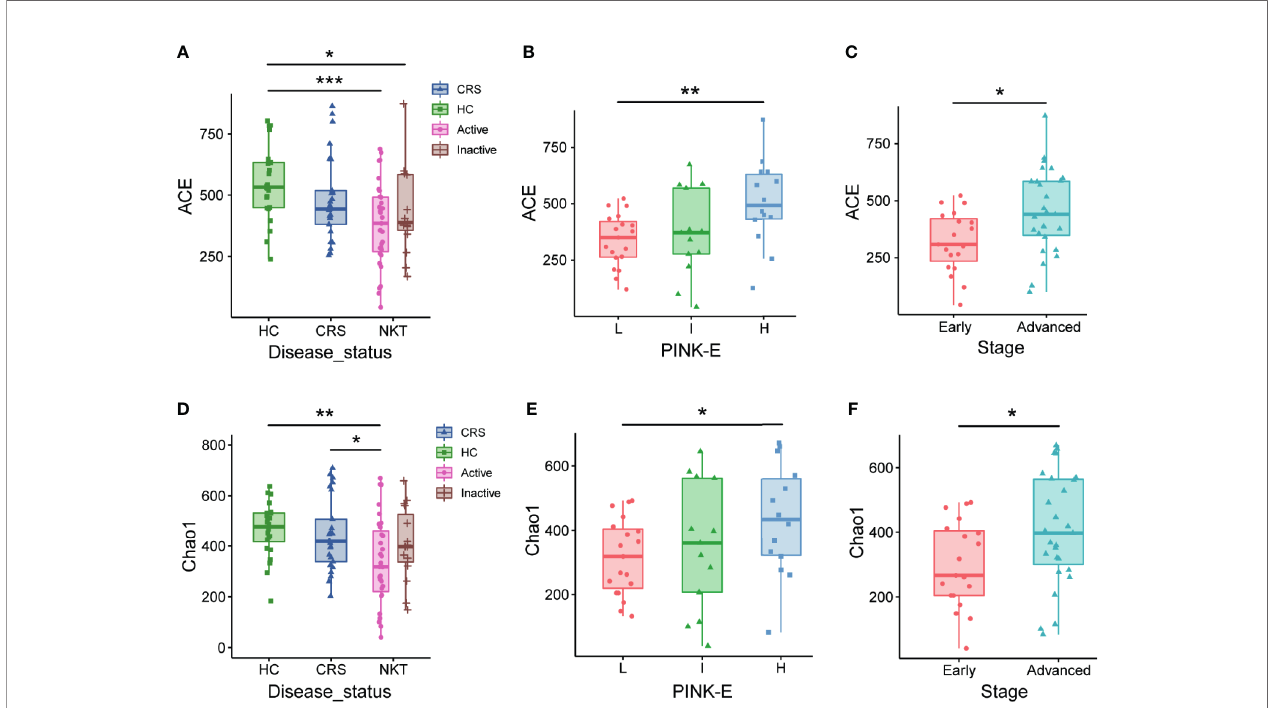
FIGURE 5 | Associations of the nasal microbiota with disease status and prognosis indicators of NKTCL. Alpha diversity of the nasal microbiota, as measured by the ACE (A – C) and Chao1 (D – F) index, in active and inactive status; low risk, intermediate risk, and high risk based on PINK-E; and early and advanced stage NKTCL patients. For the ACE index, (A) P = 0.00051, Active vs HC; P = 0.03028, Inactive vs HC; (B) P = 0.00545, L vs H; (C) P = 0.01697, Early vs Advanced. For the Chao1 index, (D) P = 0.00308, Active vs HC; P = 0.02525, Active vs CRS; (E) P = 0.03172, L vs H; (F) P = 0.0331, Early vs Advanced. HC, healthy control; CRS, chronic rhinosinusitis; NKT, natural killer/T cell lymphoma; L, low risk; I, intermediate risk; H, high risk; PINK-E, prognostic index for natural killer lymphoma- Epstein-Barr virus; * P < 0.05, ** P < 0.01, *** P <